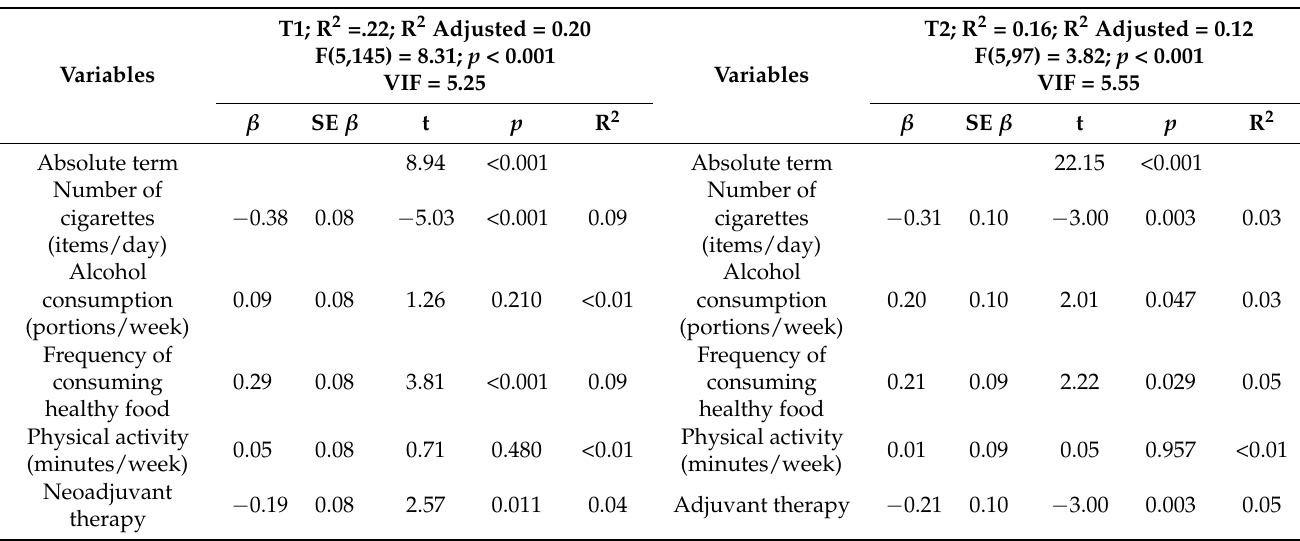
Table 6. The results of the multivariate regression analysis for QoL—emotional functioning during T1 and